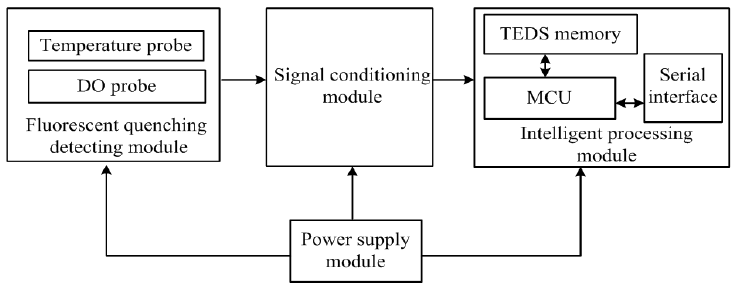
Figure 1. Overall design of the optical DO sensor.